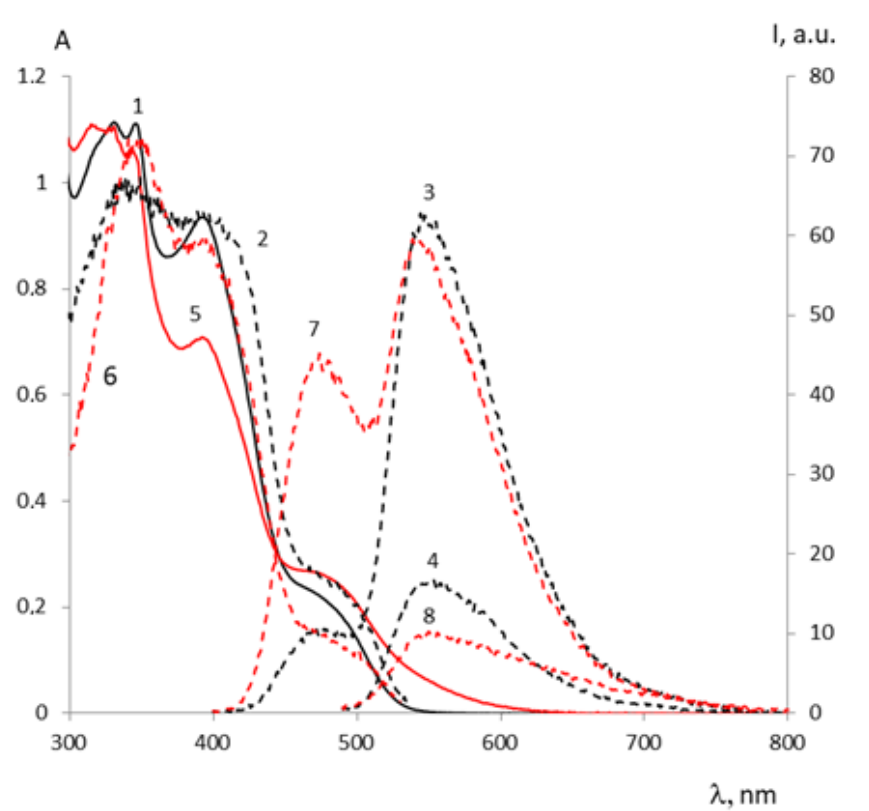
Figure 6. Absorption spectra (1, 5), fluorescence excitation spectra at λ reg = 545 nm (2, 6) and fluores-